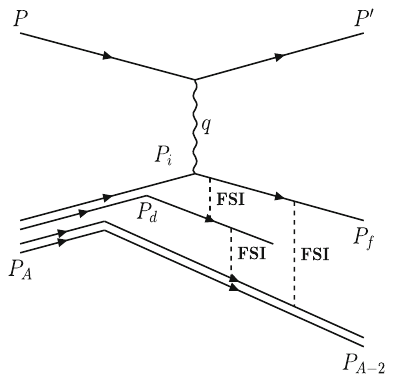
Fig. 4 2p2h process: Electron scattering from an off-shell bound pro- ton of momentum p i = k from two nucleon short range correlations (quasi-deuteron). There is an on-shell spectator (A-2) * nucleus and an on-shell spectator recoil neutron with momentum − k . The off- shell energy of the interacting bound proton is E P (cid:7) M N + k 2 − S P + N